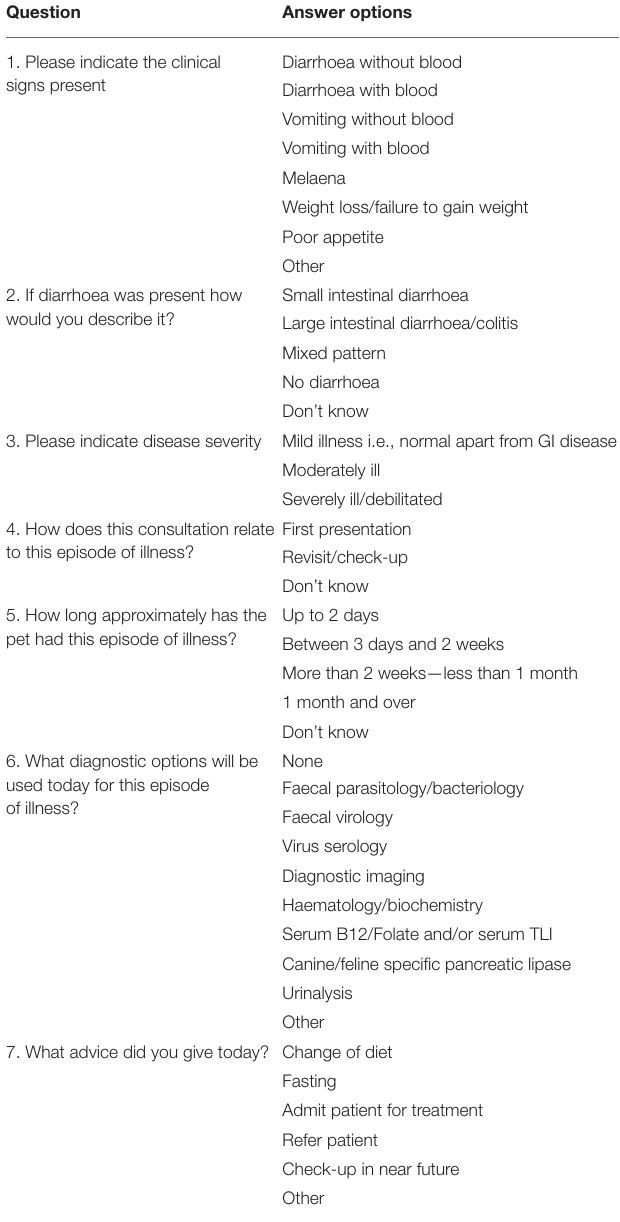
TABLE 1 | Questions provided to consulting veterinary professionals in ∼ 10% of consultations (selected at random) where they had selected “gastrointestinal” as the main reason the owner presented the animal to the